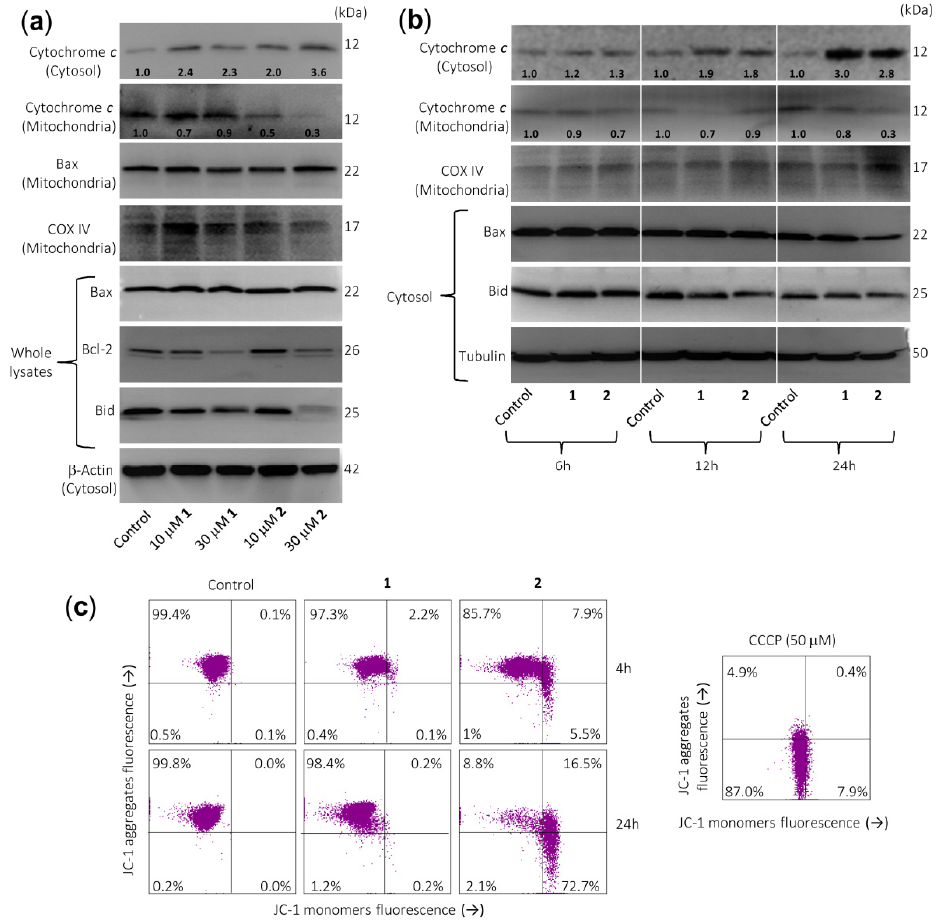
Figure 4. Sesquiterpene lactones induce the release of cytochrome c and changes on Bcl-2 family members’ expression in U-937 cells. ( a ) Cells were cultured in control conditions or in the presence of the indicated concentrations of sesquiterpene lactones for 24 h and cytosolic and mitochondrial extracts were analyzed by immunoblotting to detect mitochondrial cytochrome c release and Bcl-2 family proteins, except for Bcl-2 and Bax, which were analyzed in whole extracts. Bax was also analyzed in the mitochondrial fraction. β -Actin and COX IV (cytochrome c oxidase) were used as loading controls in cytosol and mitochondria, respectively. ( b ) Cells were incubated in control conditions or in the presence of 30 µ M compounds 1 or 2 for the indicated times and cytosolic or mitochondrial fractions were prepared and analyzed by immunoblotting using specific antibodies described in the Material and Methods section. Tubulin and COX IV (cytochrome c oxidase) were used as loading controls in cytosol and mitochondria, respectively. The cytosolic and mitochondria-enriched fractions were prepared and Western blot analyses were performed as described in the Materials and Methods. Numbers below each panel of cytochrome c indicate fold di ff erences after normalization to the corresponding loading control ( β -actin, tubulin, or COX IV). ( c ) Sesquiterpene lactone 2 reduces the mitochondrial membrane potential ( ∆Ψ m). Cells were incubated in control conditions or in the presence of 30 µ M compounds 1 or 2 for 4 h or 24 h, and ∆Ψ m were analyzed by flow cytometry using the fluorescent probe JC-1. The results are representative of three separate experiments. Carbonyl cyanide m -chlorophenylhydrazone (CCCP, 50 µ M) was used as a positive control.